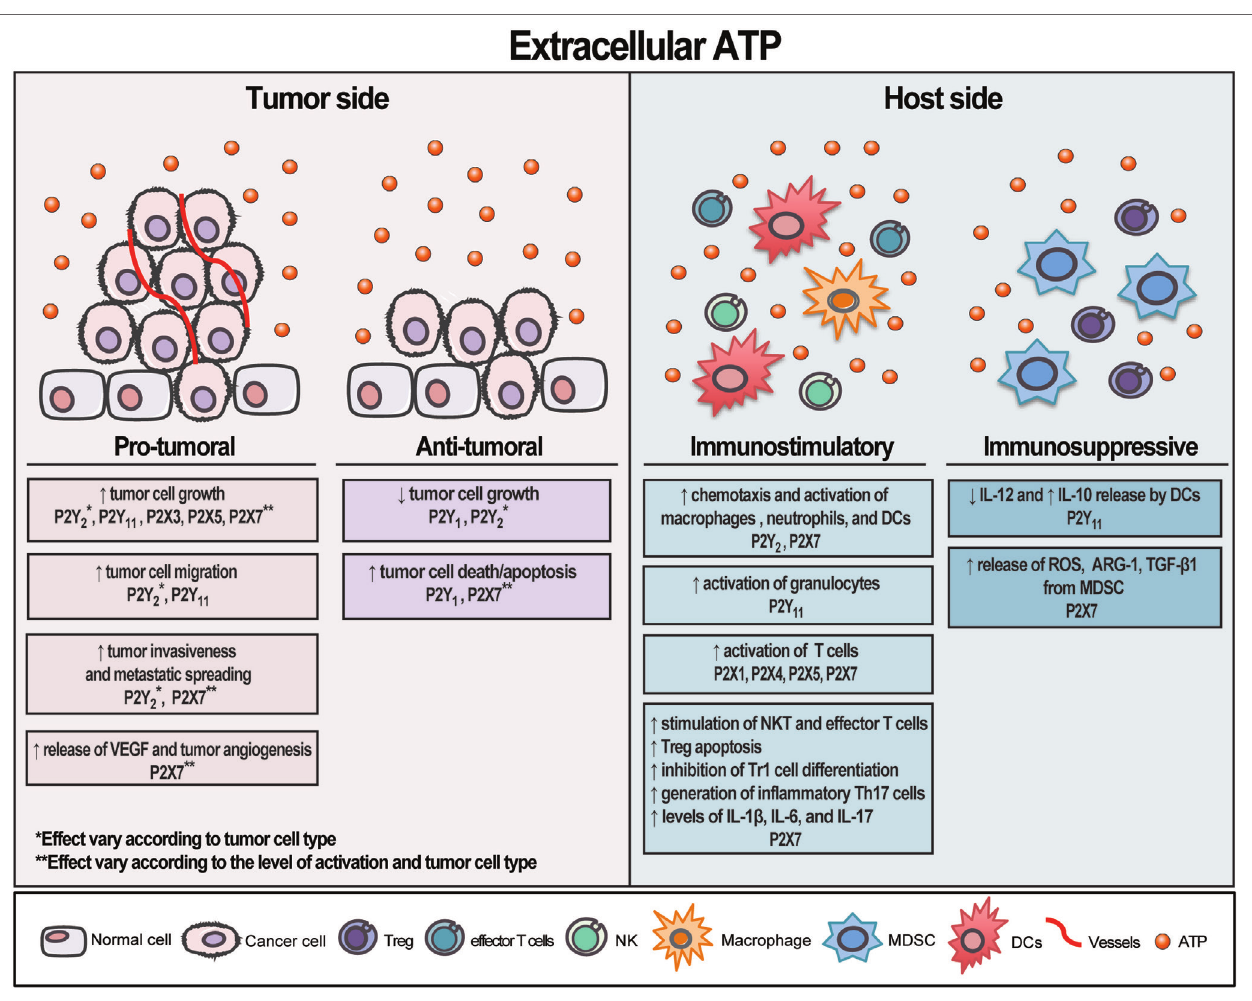
FigURe 1 | Schematic illustration showing extracellular adenosine triphosphate (eATP) contrasting effects on tumor and host side. eATP can trigger different and opposite effects on both tumor and host cells depending on the cell type and receptor activated. The final result—either stimulating or restraining tumor growth—will depend on the eATP levels, the panel of P2 receptor subtypes and CD39/CD73 expression by tumor and immune cells present in the tumor microenvironment. Overall, eATP is a potent pro-inflammatory mediator, mostly boosting immune cells